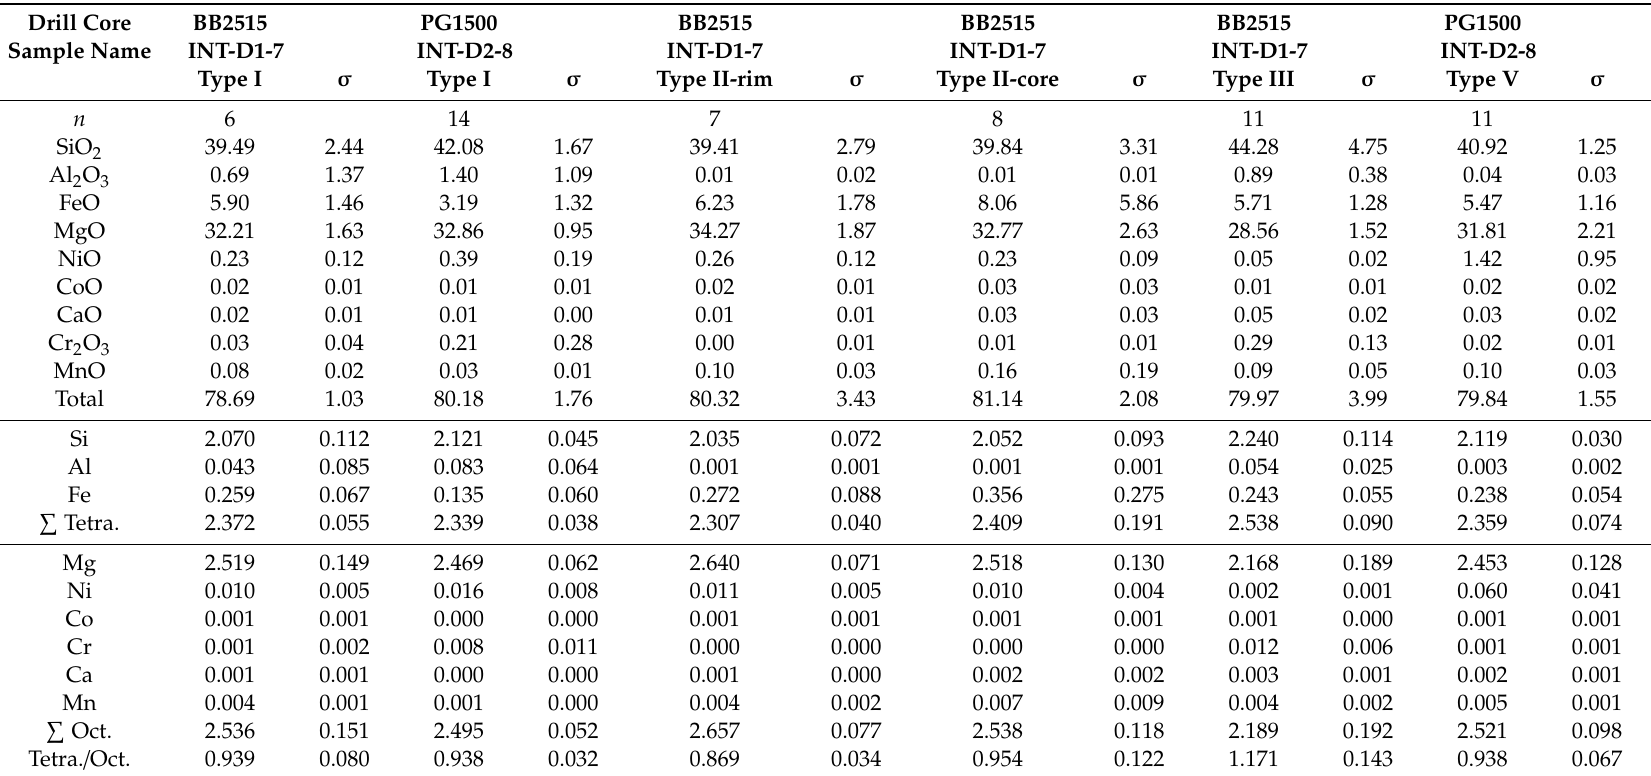
Table 3. Average chemical compositions (wt%) and structural formula (apfu) of the di ff erent vein serpentines in the